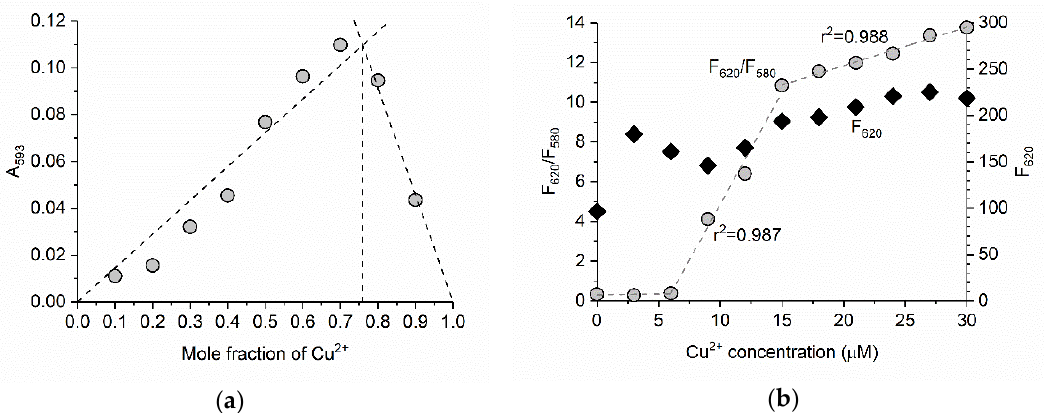
Figure 5. ( a ) Job’s plot of BODIPY 1 and Cu 2+ system. The total concentration of BODIPY 1 and Cu 2+ was 9 µM and absorbance at 593 nm (A 580 ) was plotted. ( b ) Plot of fluorescence intensity at 620 nm ( F 620 ) and ratio of fluorescence intensities ( F 620 / F 580 ) of BODIPY 1 (3 µM) versus increasing Cu 2+ concentration (0–30 µM) in acetonitrile. The excitation wavelength was 550 nm.